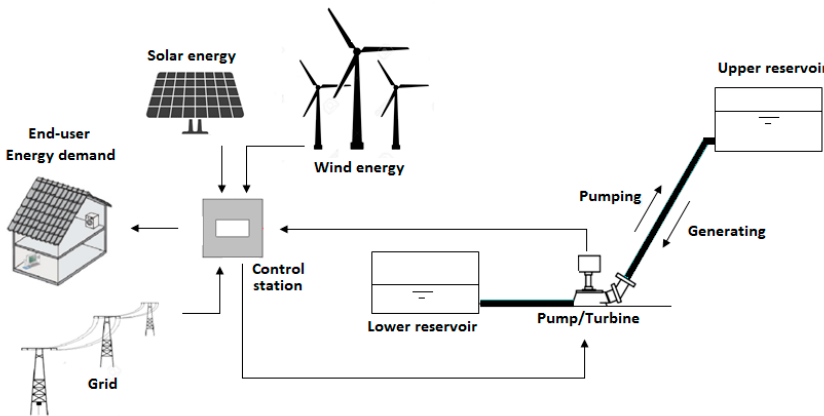
Figure 1. A hybrid hydro-wind-solar system with pumped storage system.